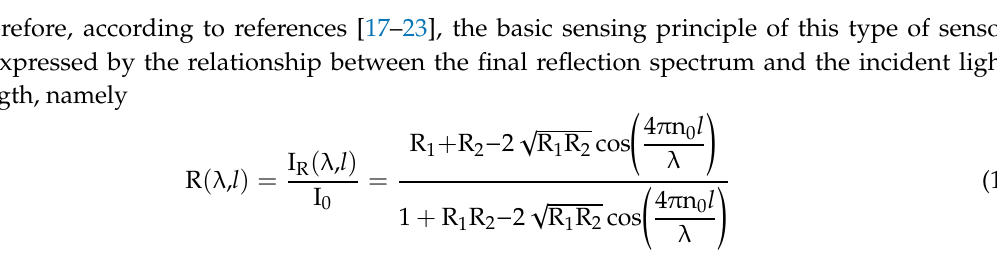
Figure 1. Sensing principle of the extrinsic fiber-optic Fabry–Perot (F-P) acoustic sensor.